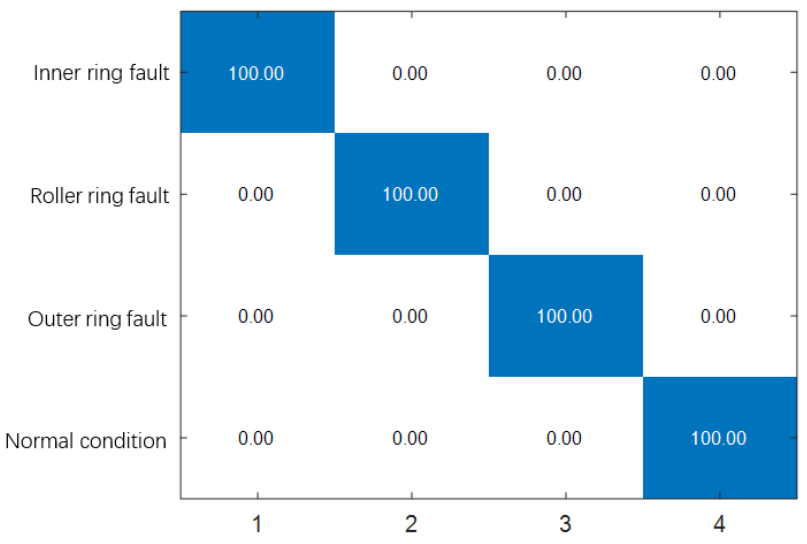
Figure 10. VMD-CMDE-PSO-DBN fault recognition rate.